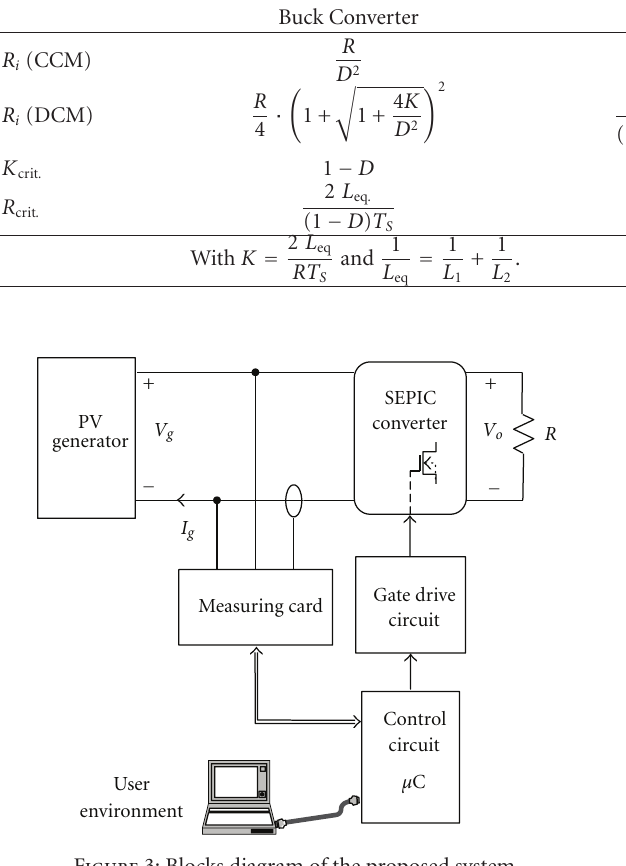
Figure 3: Blocks diagram of the proposed